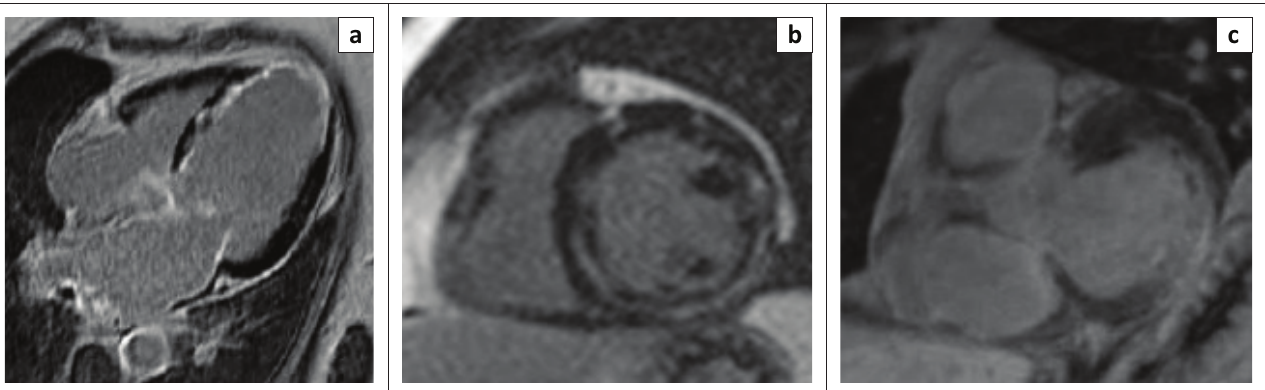
FIGURE 2: Late gadolinium enhancement showing scar patterns in different cardiomyopathies: (a) ischaemic cardiomyopathy, with subendocardial and transmural components; (b) cardiac sarcoid, with a patchy multifocal pattern; and (c) myocarditis, with a primarily subepicardial pattern.